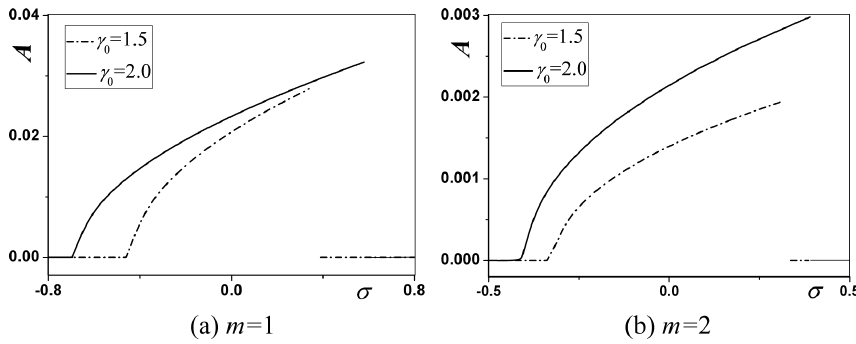
Fig. 9. Effects of the mean axial speed.